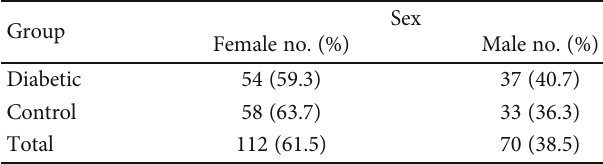
Table 1: Number of subjects enrolled in the study.